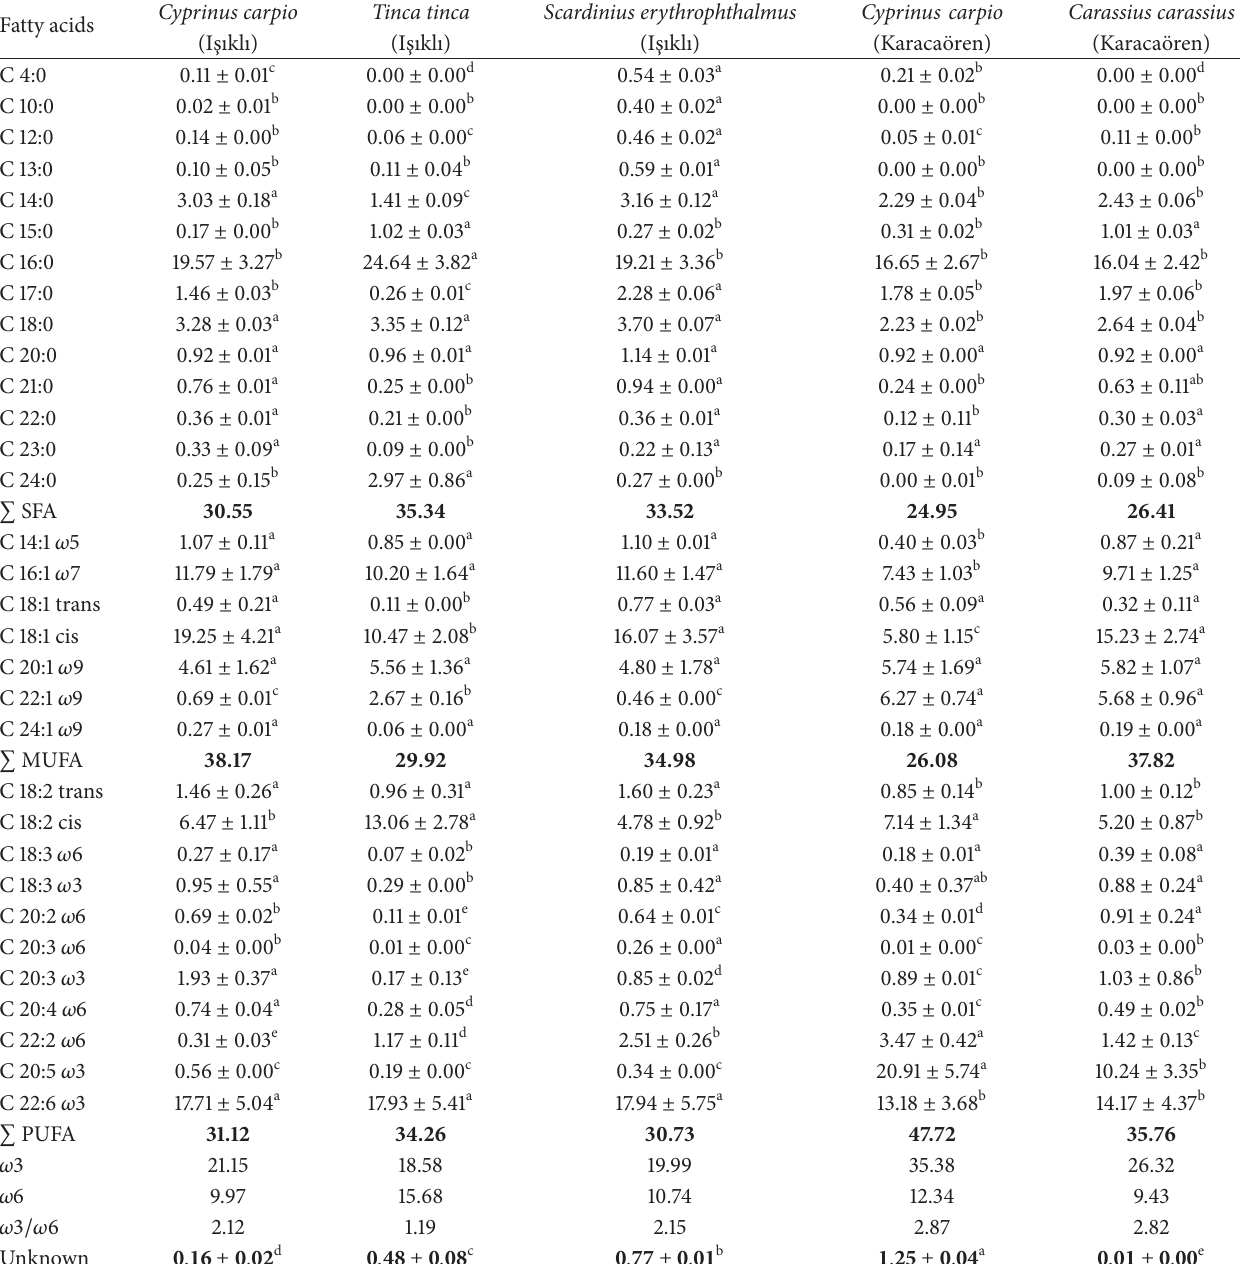
Table 1: Fatty acid composition of fish grown in Karaca¨oren and Is¸ıklı Dam